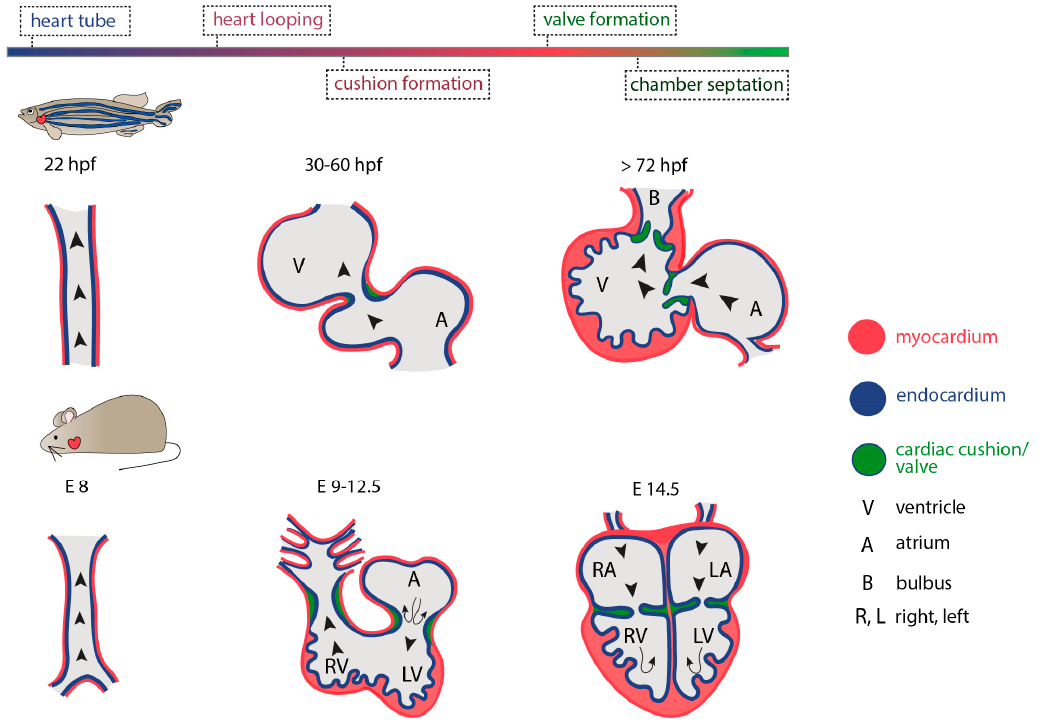
Figure 4. Hemodynamics and stages of cardiogenesis in zebrafish and mammals. In both zebrafish and mammals, shear forces that occur from the oscillatory/retrograde blood flow and are driven by cardiac contractility and heart looping, direct valvulogenesis. Hence, cardiac valves are formed following the initiation of heart function. Valve cells originated from endocardial cells forming cardiac cushions. Valve Endothelial Cells (VECs) and Valve Intersitial Cells (VICs) can be identified in both systems. In zebrafish, embryonic cushions give rise to cardiac leaflets that invaginate and generate cardiac valves. In contrast, in mammals, endocardial cells undergo an endothelial-to-mesenchymal transition, delaminate generate cardiac valves upon invasion into the cardiac jelly. The outer layer of epicardial cells and the cardiac jelly is omitted in all schemes for figure clarity.